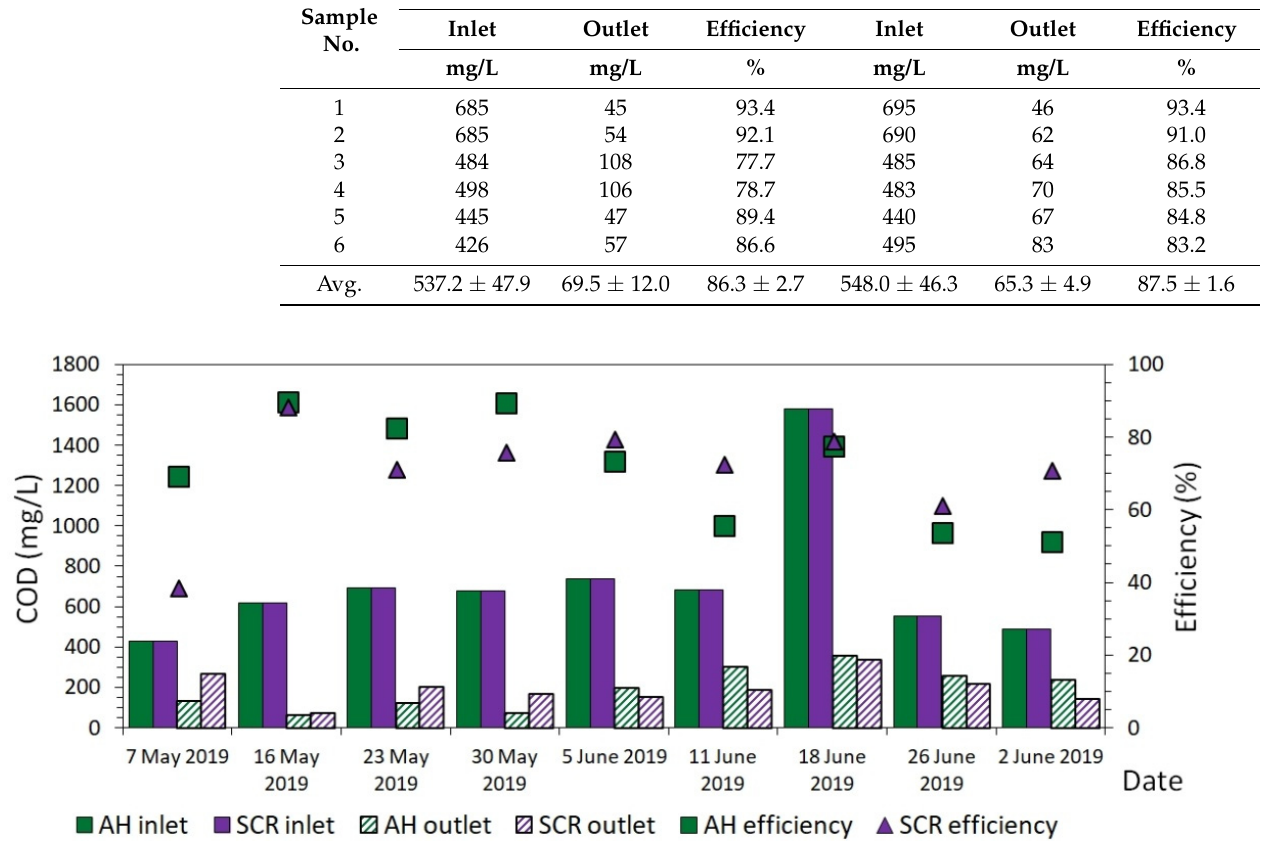
Figure 3. Inlet and outlet COD and removal efficiencies at preliminary stage.